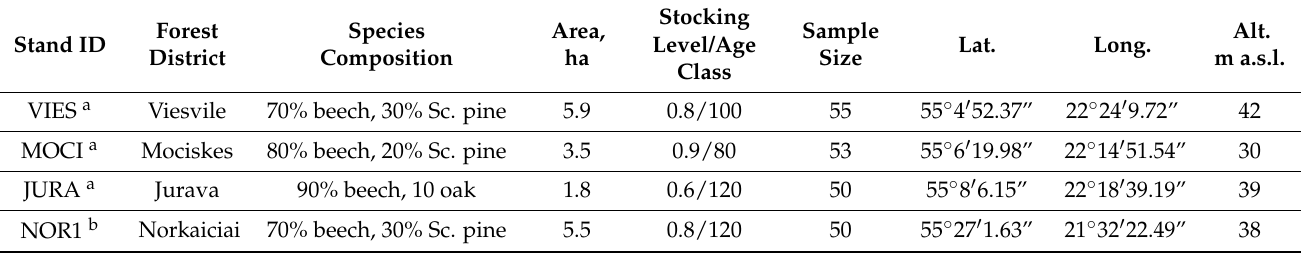
Table 1. Characteristics of the sampled stands of European beech in seaside lowland of west- ern Lithuania (the mildest climatic zone in Lithuania, with mean annual temperature (MAT) of 7.44–7.65 ◦ C [23]). All the stands were artificially established. Age of the mature overstory trees is given (estimated by coring). All stands are on normally irrigated medium fertility sandy sites. Species composition refers to the mature